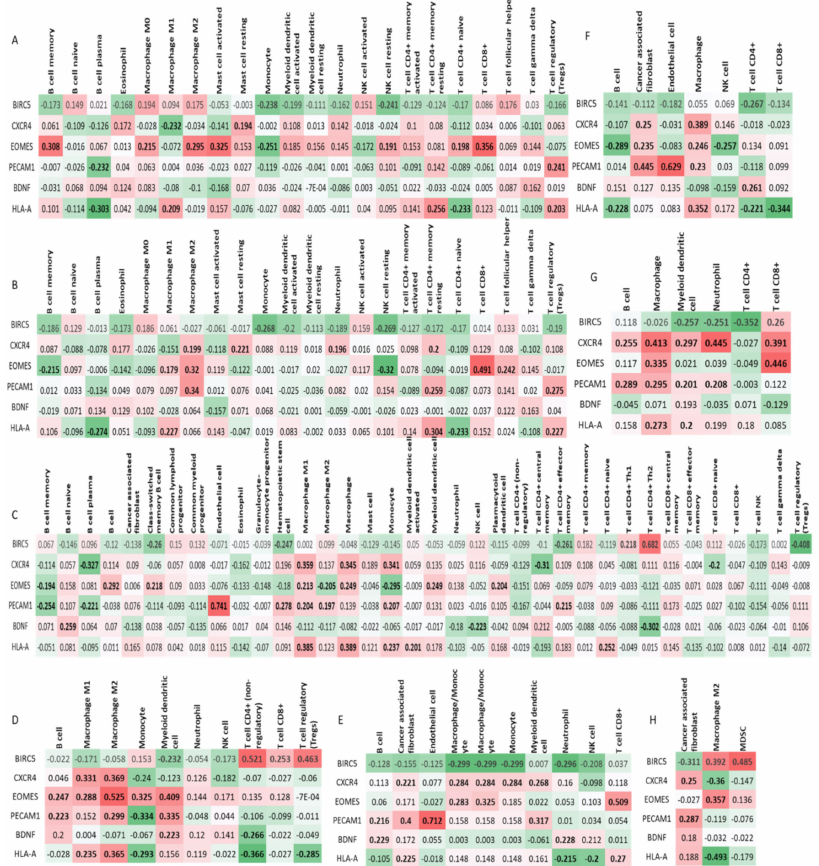
Figure 6. Timer analysis heatmaps of 7 algorithms for the 6 genes ( A ) CIBERSORT, ( B ) CIBERSORT- ABS ( C ) XCELL ( D ) QUANTISEQ ( E ) MCPCounter ( F ) EPIC ( G ) TIMER, and ( H ) TIDE. p < 0.05 is given in